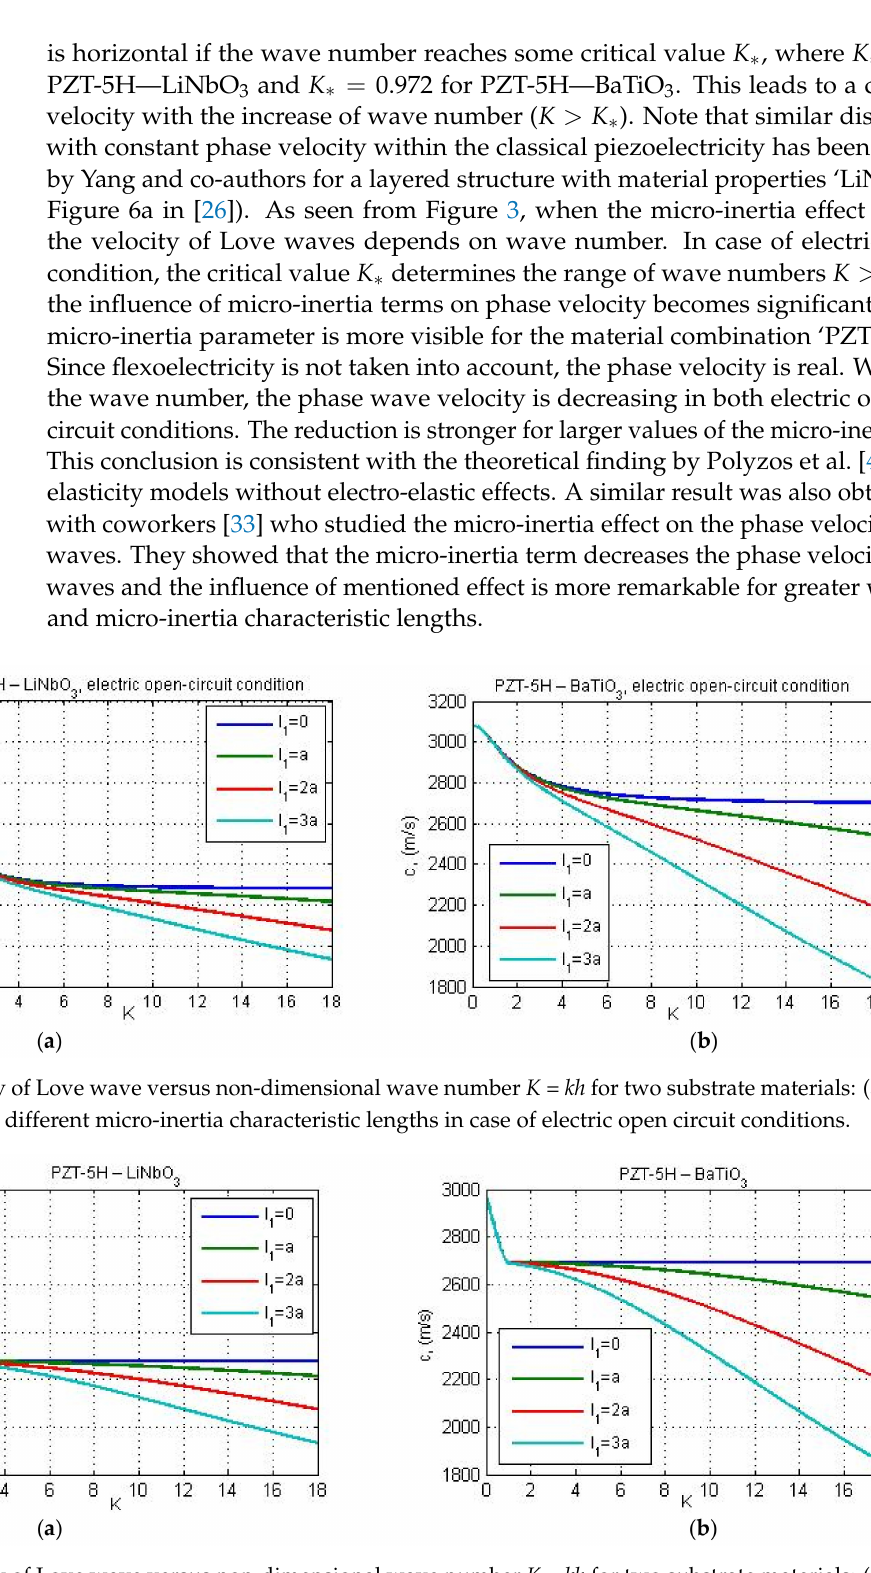
Figure 3. Phase velocity of Love wave versus non-dimensional wave number K = kh for two substrate materials: ( a ) LiNbO 3 , and ( b ) BaTiO 3 and for different micro-inertia characteristic lengths in case of electric short circuit